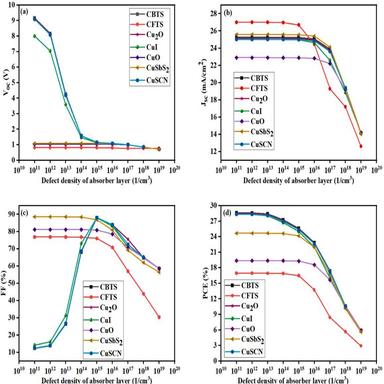
Defect density (Nt) of absorber layer versus SC performance parameters with ETL ZnSe.